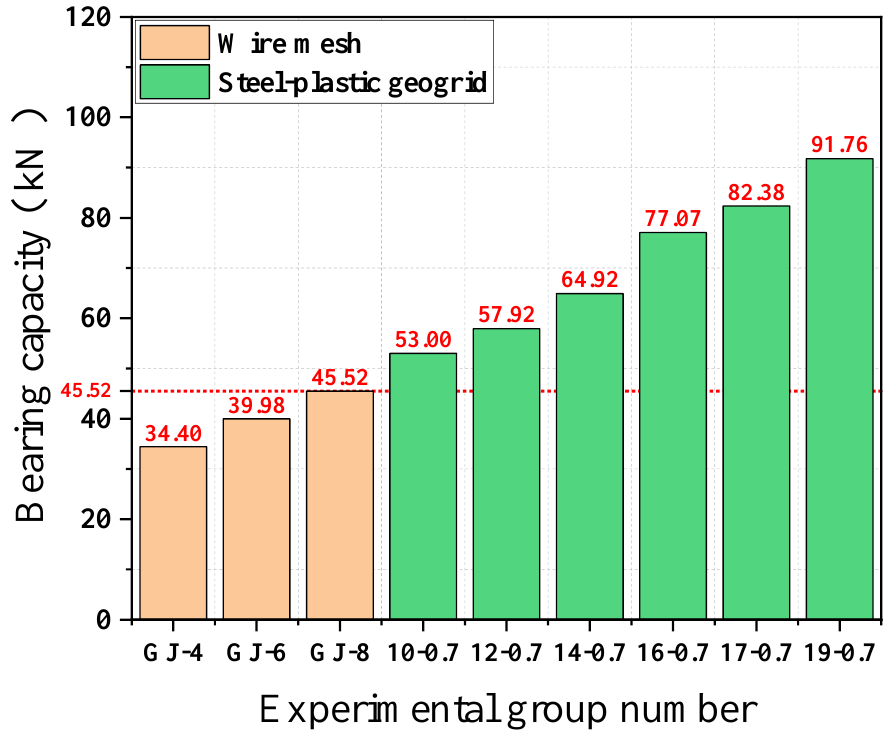
Figure 10. Comparison of peak mesh load-bearing capacity.